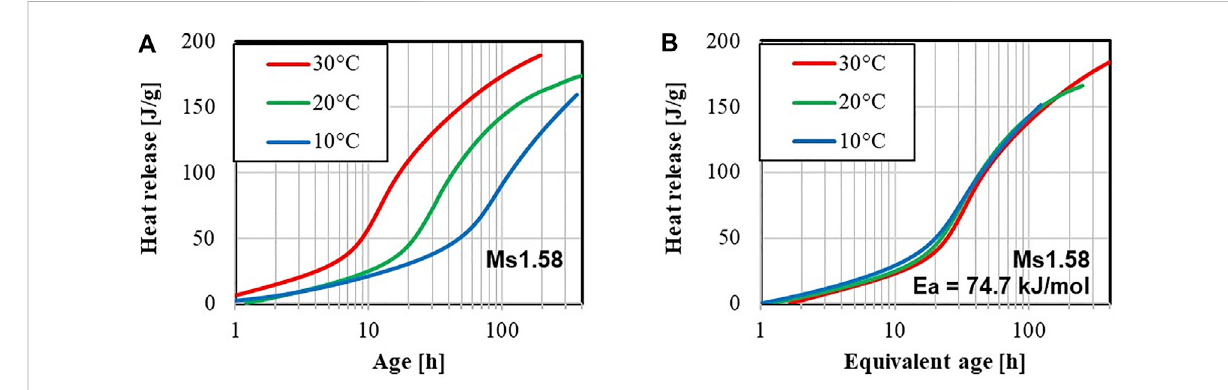
FIGURE 5 Cumulative heat of Ms1.58 (A) and results of activation energy for Ms1.58 according to the method of superposition (B) .